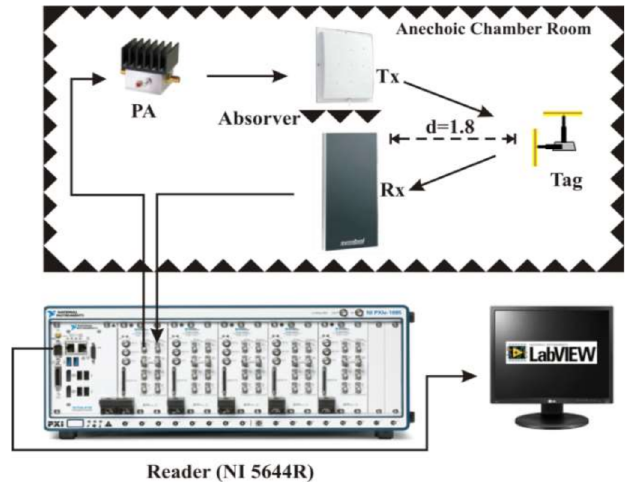
Figure 8. Experimental